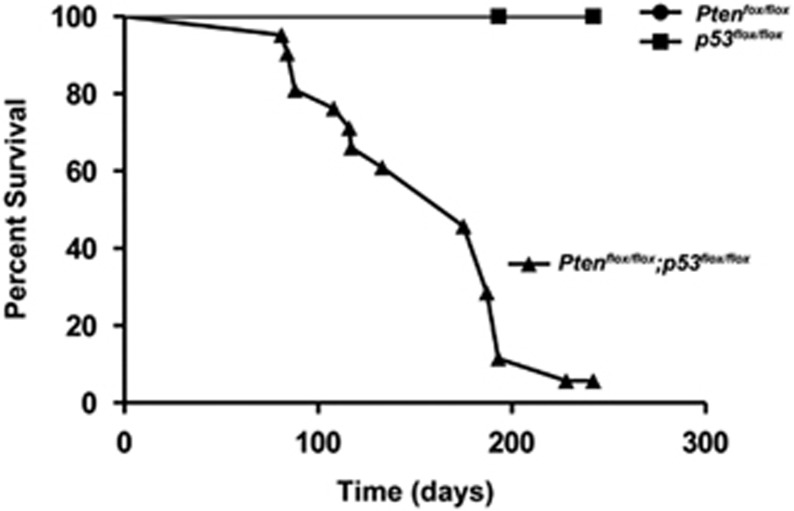
Survival curve of p53flox/flox, Ptenflox/flox and Ptenflox/flox; p53flox/flox mice. Adenovirus-cre injection into adipose tissue of male and female p53-floxed, and Pten-floxed allele mice in combination leads to liposarcoma at the indicated time points. p53flox/flox (n= 8), Ptenflox/flox (n= 8) and Ptenflox/flox; p53flox/flox (n= 22)